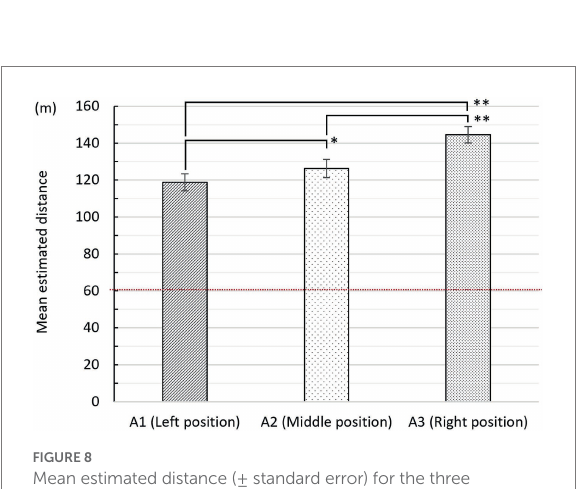
FIGURE 8 Mean estimated distance (± standard error) for the